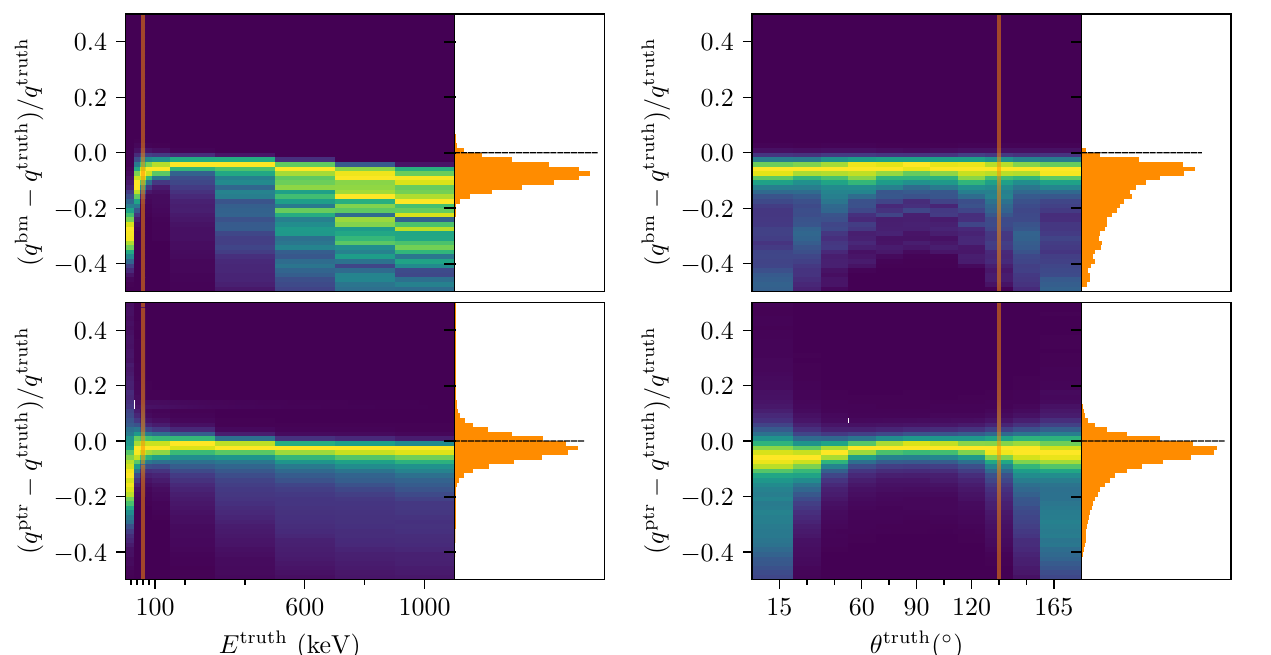
Fig. 8 The fractional error in the primary charge q determination for benchmark (top) and ptr (bottom) methods, versus primary track energy (left) and polar angle (right). The color/shade indicates the num- ber of events in 2D bins, independently normalized in each column to